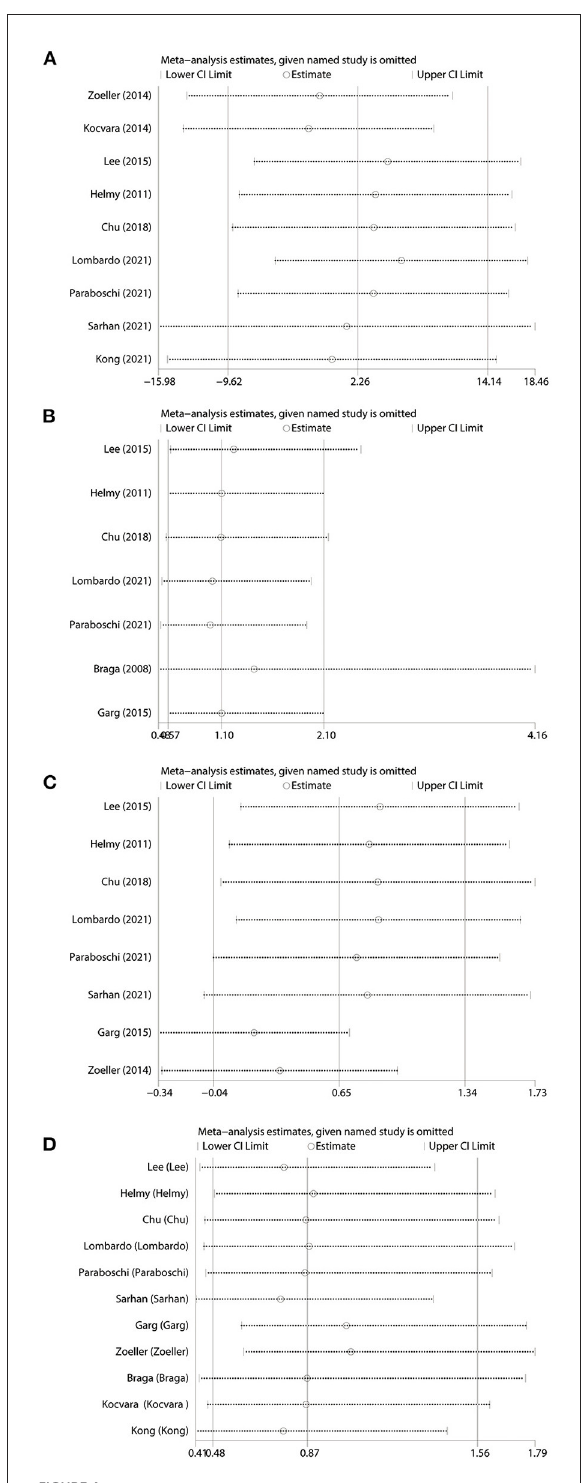
FIGURE4 Sensitivity analysis. (A) Operative time. (B) Operative success rate. (C) Length of hospital stay. (D) Complication. Studies are removed one by one to recalculate the combined effect size, and compare the difference with the initial effect